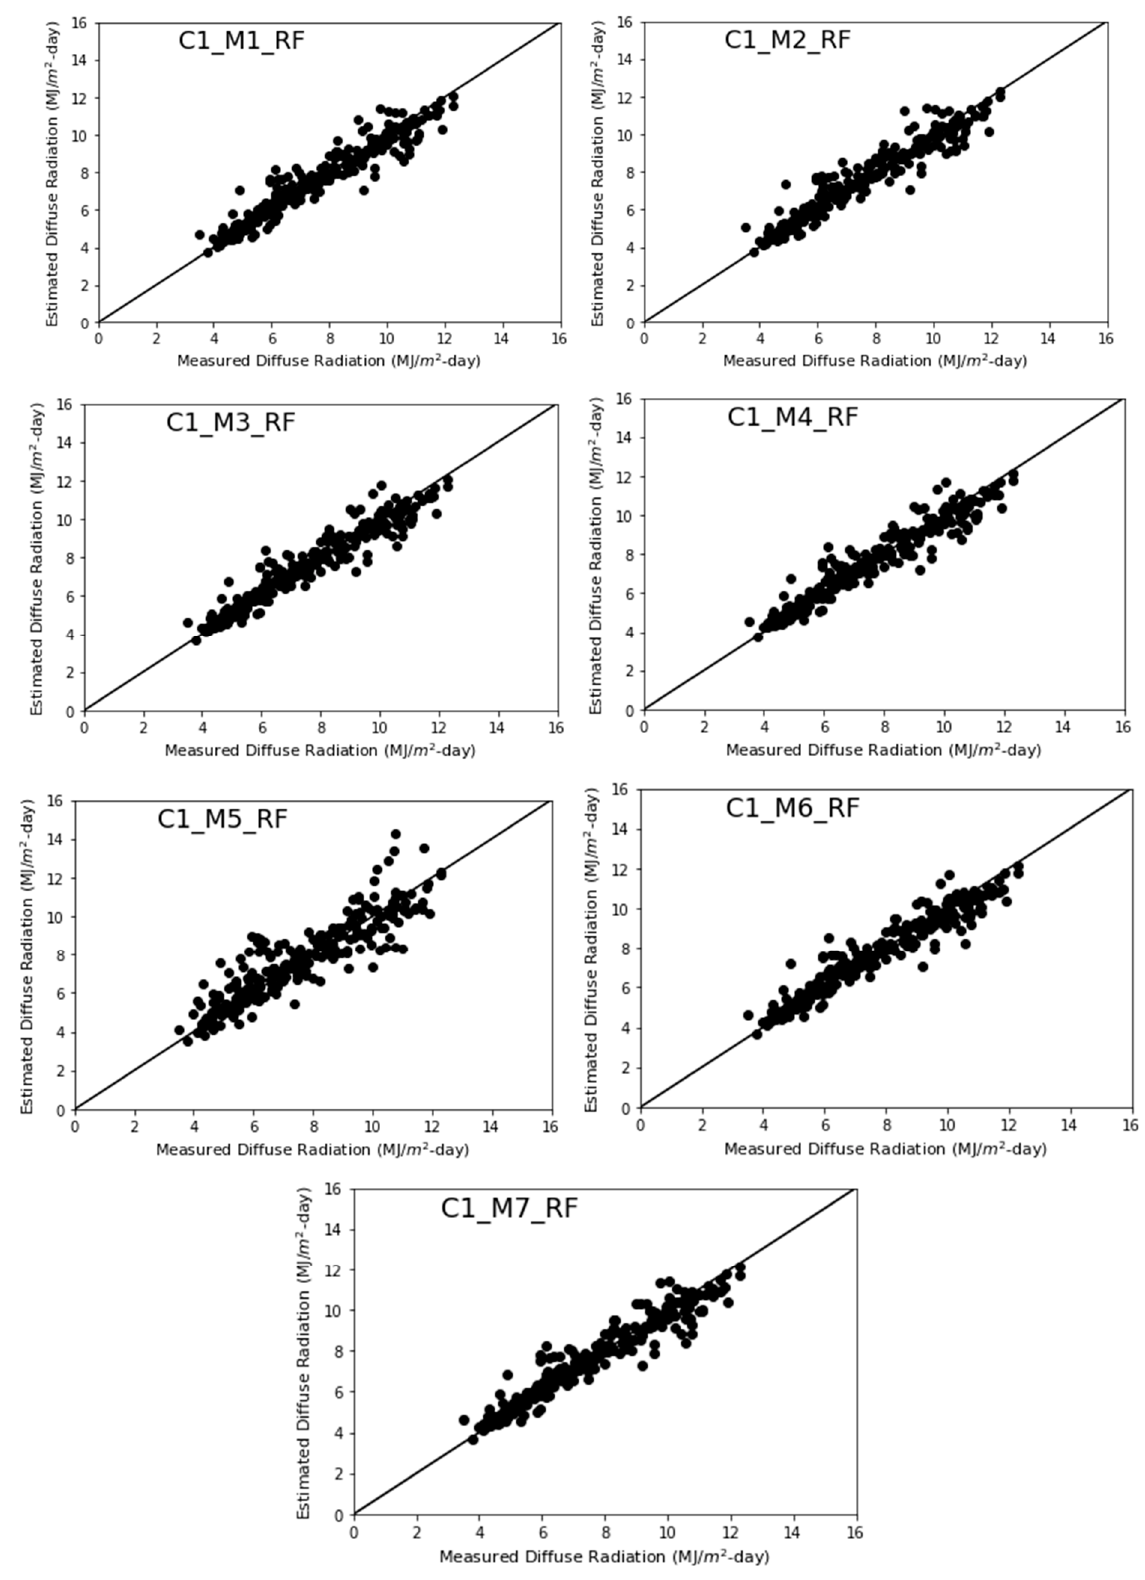
Figure 3. Plot depicting predicted and measured DSR from RF ML models (Category 1).